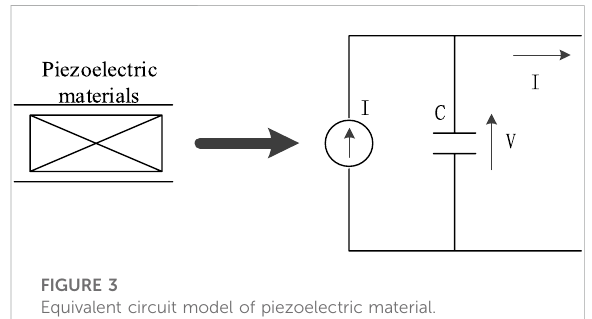
FIGURE 3 Equivalent circuit model of piezoelectric